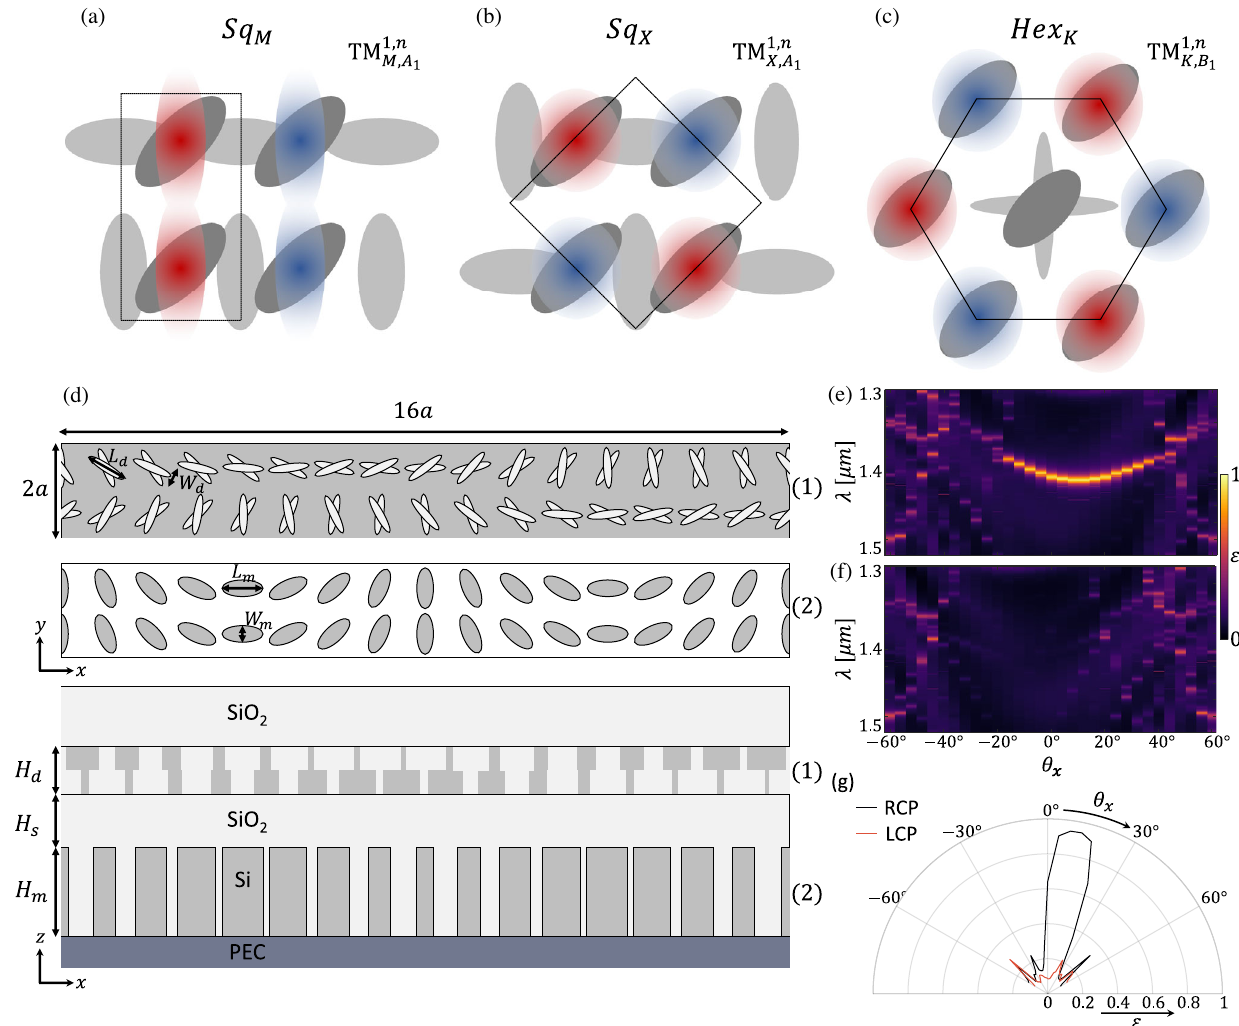
FIG. 11. Additional example geometries. (a) – (c) Three lattices controlling three different modes with both Q factor and polarization angle control by varying the ellipticity and the in-plane orientation angles of the light-gray ellipses, respectively. The lattices and the targeted modes depicted are named according to the conventions in Ref. [54]. (d) An alternative configuration in the out-of-plane direction, having two elements: Element (1) is a dimerized PCS supporting a chiral QBIC, and element (2) is a monomer local metasurface atop a perfect electric conductor (PEC). (e),(f) RCP and LCP response for the device shown in (d). (g) Angular emissivity profile at the band-edge frequency, showing unidirectional emission of the designed